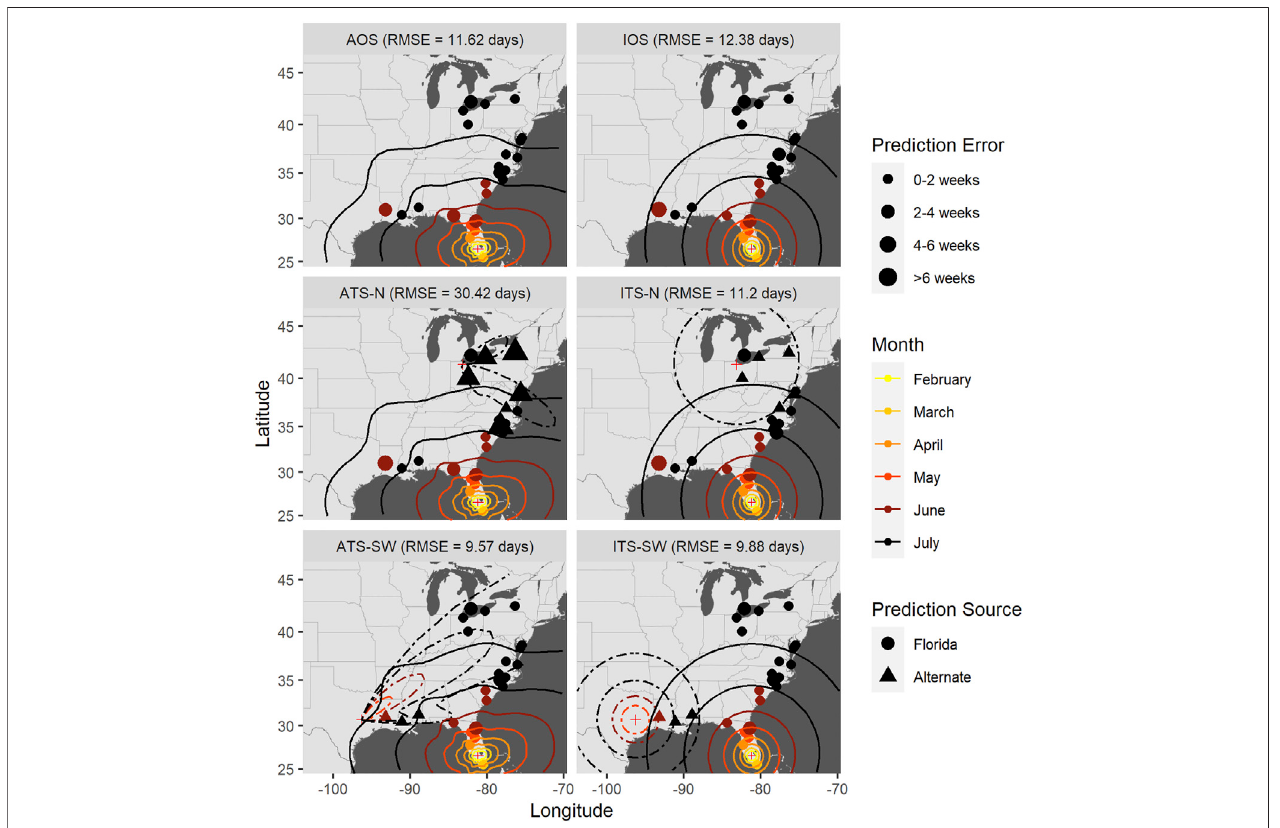
FIGURE7| Time-of-occurrencepredictionerrorsforpredictionsfrom isotropicandanisotropicone-andtwo-sourcemodels fi ttodatafromsentinel plotsin2008, withcontoursrepresentingestimateddiseasefrontovertimeaccordingtothemodels.Thetwo-sourcemodelswereeach fi twithtwoalternate(non-FL)sourcelocations: anorthernandasouthwesternlocation.Eachpanelshowsresultsaccordingtoadifferentmodel:isotropicone-source(IOS);isotropictwo-source(ITS);anisotropicone- source (AOS); and anisotropic two-source